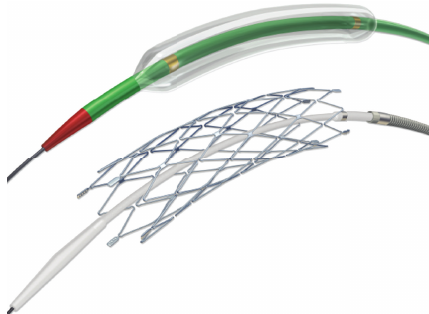
Figure 2: Stent and balloon catheter commonly used in